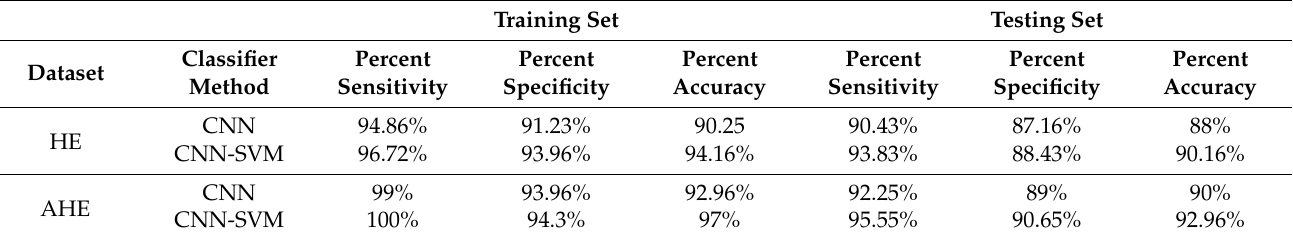
Table 6. Training and testing validation results of the HE and AHE dataset based on sensitivity, specificity, and accuracy. Training Set Testing